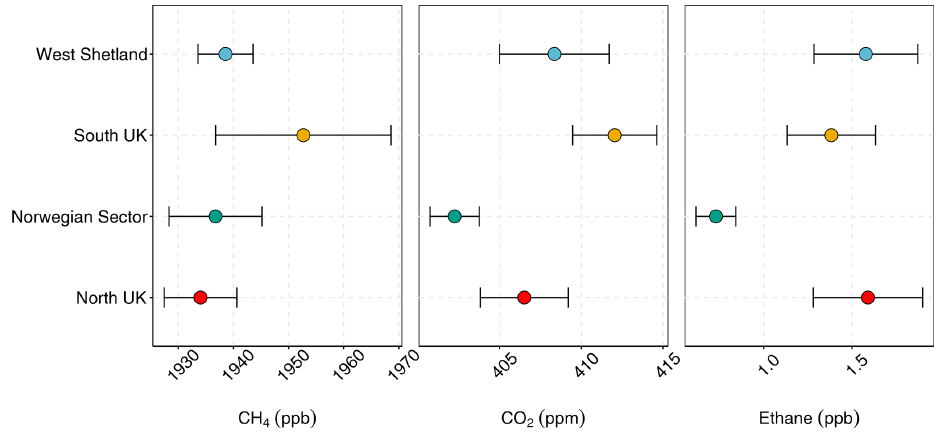
Figure A1. Mean background mixing ratios of CH 4 , CO 2 and ethane from all flights in each sampling region. Error bars represent 1 standard error.